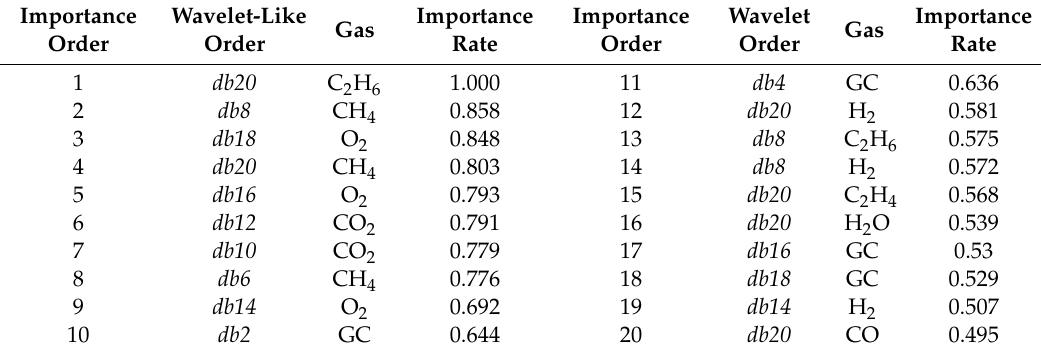
Table 5. Importance order and rate of each wavelet order for gas concentration.